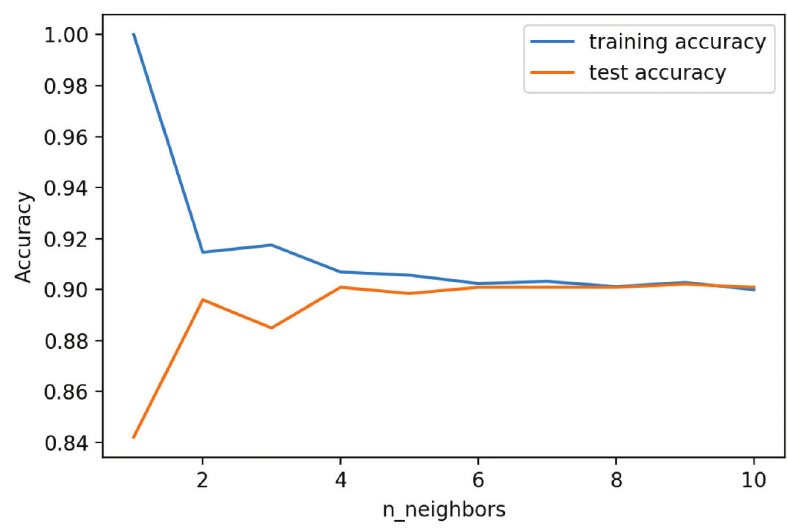
Figure 4. Accuracy curve of the training set and the test set of the F3 model.